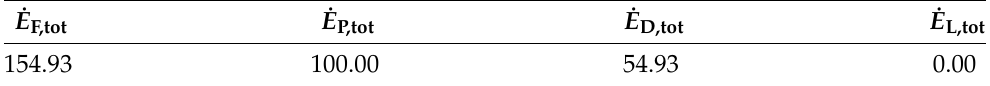
Table 6. sCO 2 power cycle—Results of the exergy analysis, overall process. All values given in MW. ˙ E F,tot